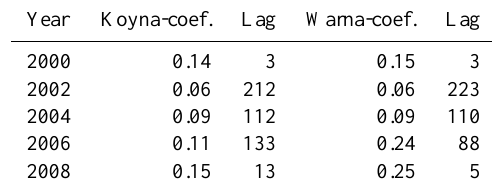
Fig. 4. (a) The maximum correlation coefficient for different years. (b) The time lag for different years. (c) The diffusivity values for different years. (d) The number of events for different years.